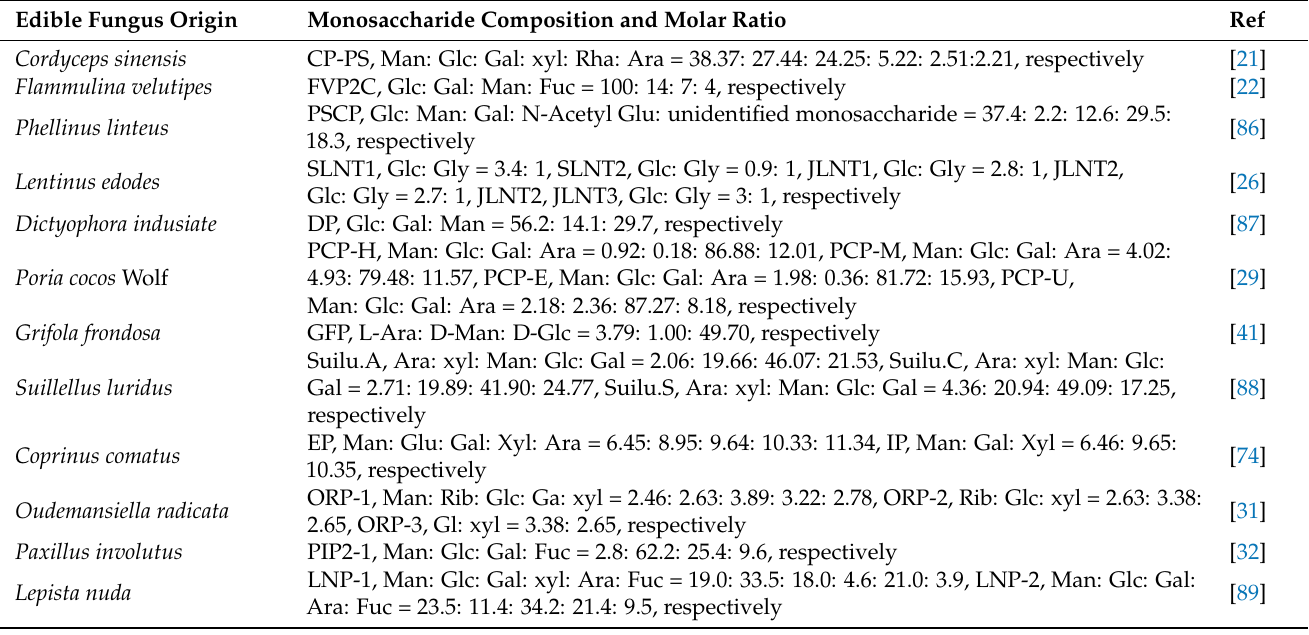
Table 2. Monosaccharide composition of different edible fungus